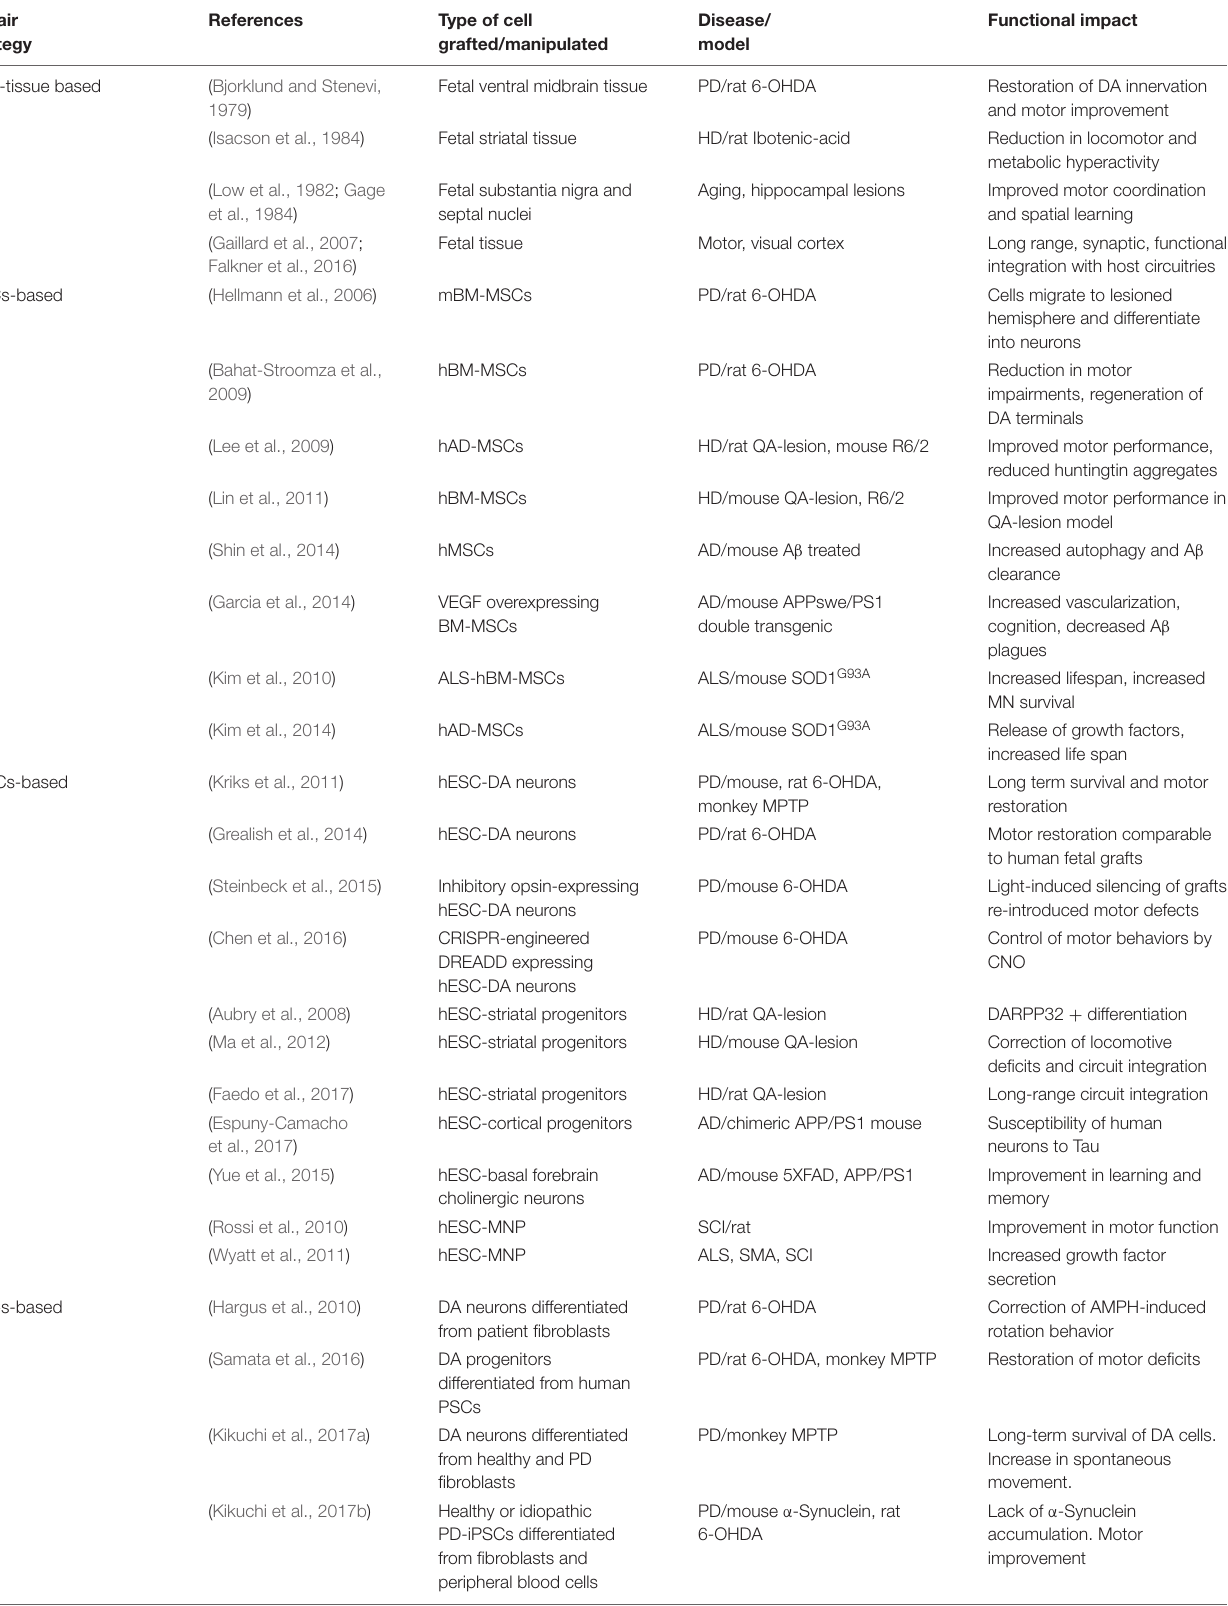
TABLE 1 | Summary of select studies involving cell-transplant based repair strategies in in vivo pre-clinical neurodegenerative disease models. Repair